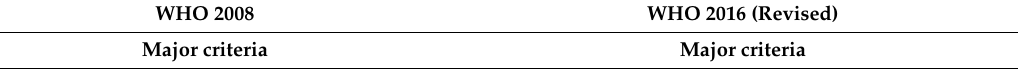
Table 1. The evolution of essential thrombocythemia diagnostic criteria according to World Health Organization